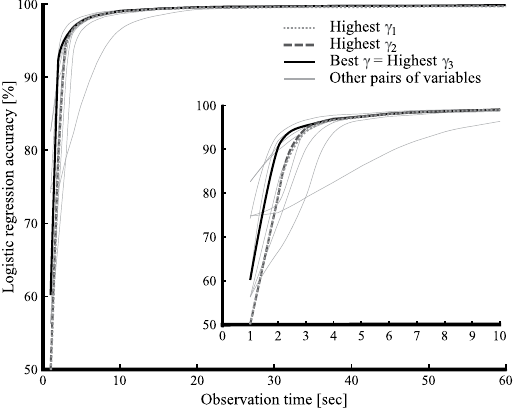
Figure 5. Evolution of the classification accuracy with decreasing observation time: The accuracies of multivariate logistic regressions in discriminating the Normal Sinus Rhythm (NSR, N = 900) and Atrial Fibrillation (AF, N = 580) states for RR intervals measured over observation times from 1 to 60 s. The dotted grey line represents the fitted accuracy curve for the best single variable selected through γ -analysis (best γ 1 ), the dark dashed grey line represents the fitted accuracy curve for the best pair of variables selected through γ -analysis (best γ 2 ), the black line represents the fitted accuracy curve for the best triplet of variables selected through γ -analysis (best γ 3 ), and the thin grey lines represent other combinations of two